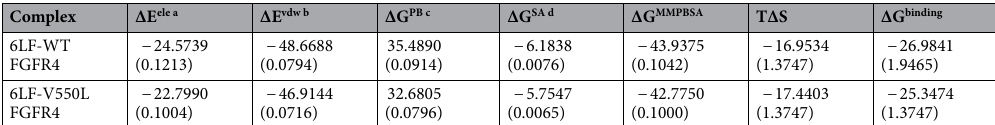
Table 2. Free energy results from MMPBSA. Standard errors of corresponding values are given in parentheses. All units are given in kcal/mol. a ΔE ele : Electrostatic energy. b ΔE vdw : Van der Waals energy. c ΔG PB